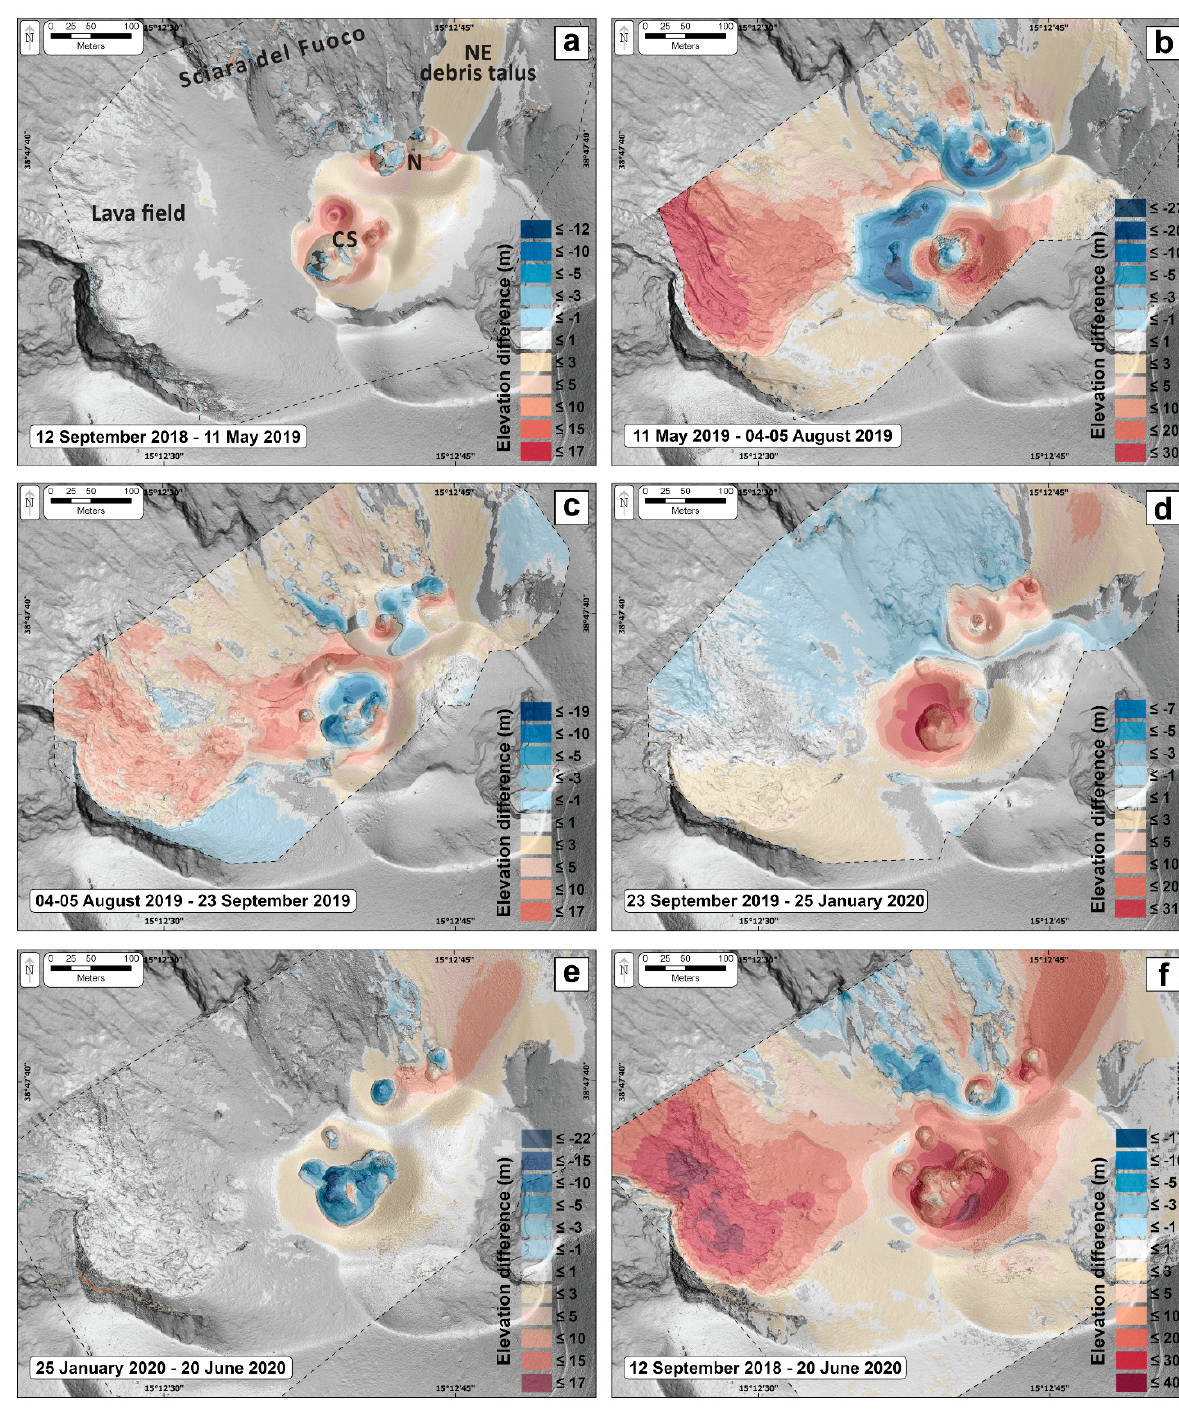
Figure 4. ( a – f ) Elevation difference maps highlighting changes in the Stromboli summit area for the period September 2018–June 2020. Blue areas indicate material loss, whereas yellow/red areas indicate material gain. The black dashed lines enclose the Area of Interest (AOI) for each time interval. Description in Section 3.2.